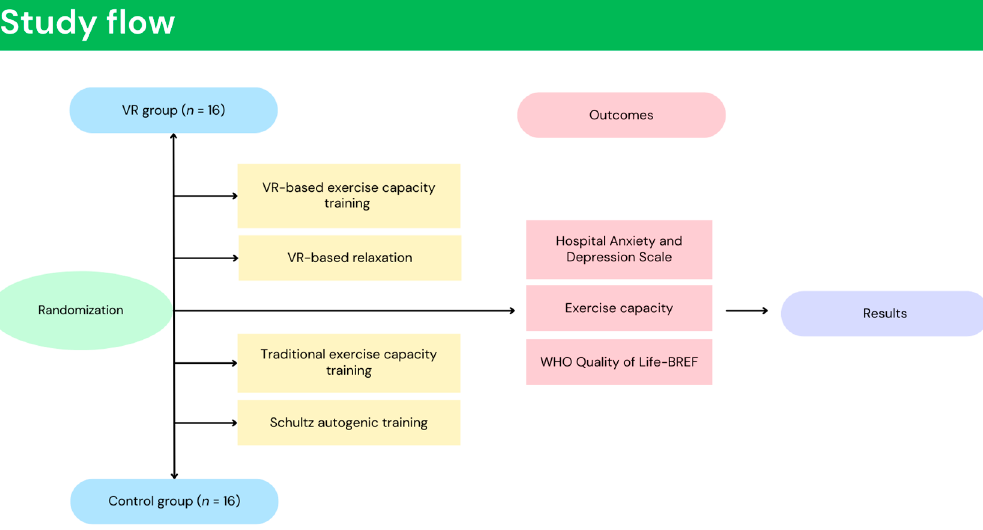
Figure 1. Study flow.